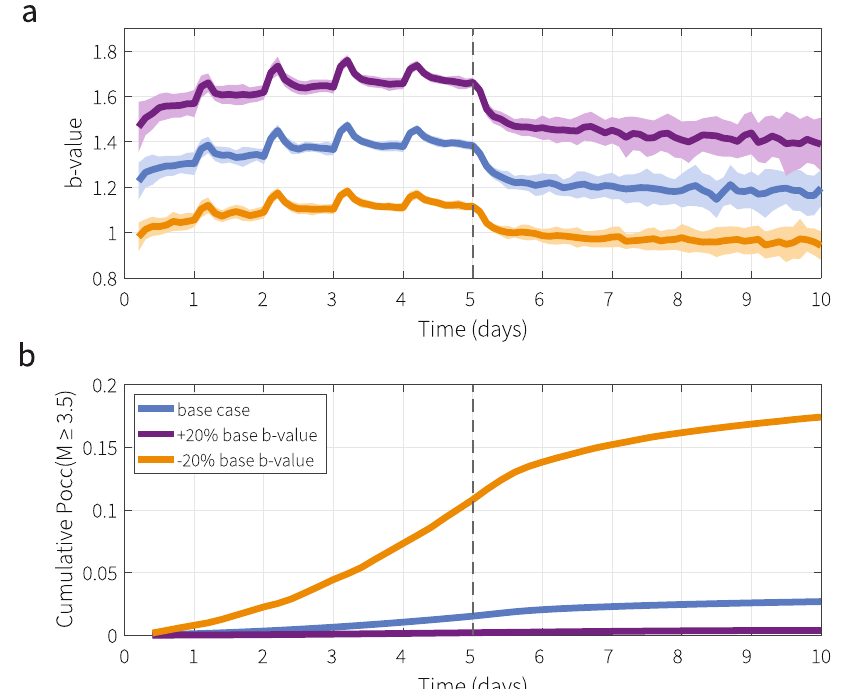
Fig. 4 In fl uence of the regional state of stress on b -value and associated risk/hazard. a Evolution of the b -value over time with a ± 20% b -value variation around the base case (shaded area± one standard deviation); b Corresponding cumulative probability of occurrence of an event of a magnitude ≥ 3.5.